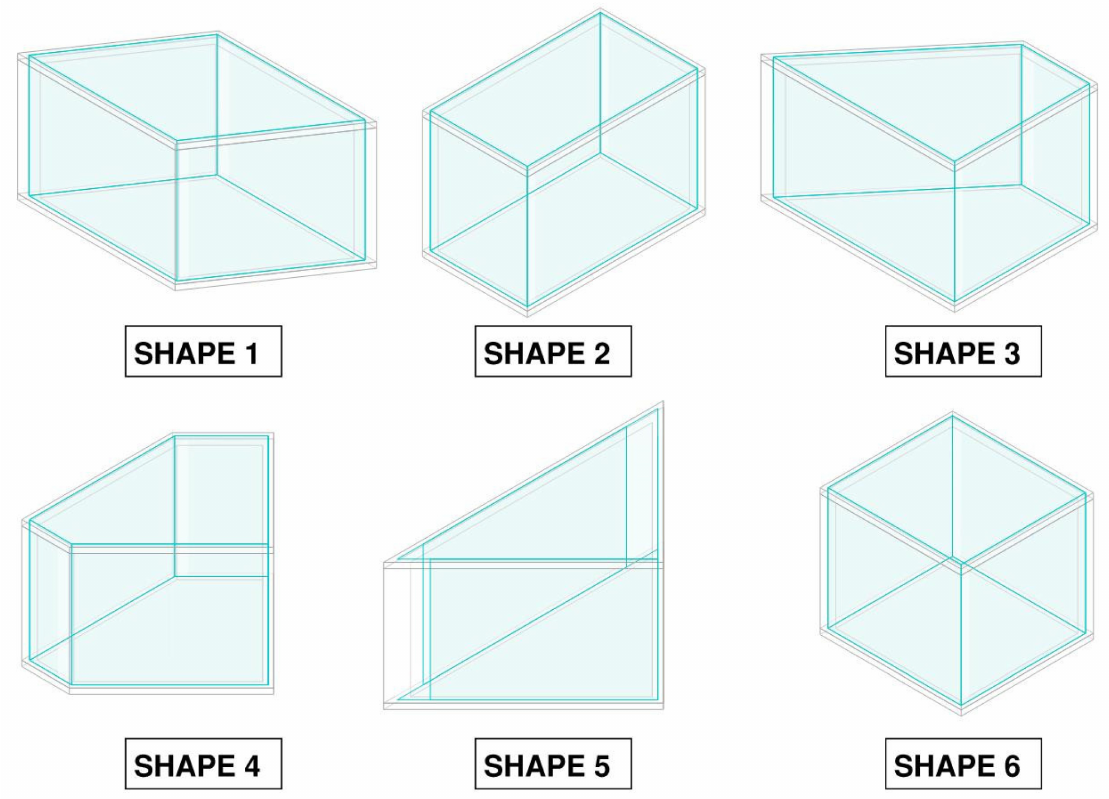
Figure 1. Revit analytical